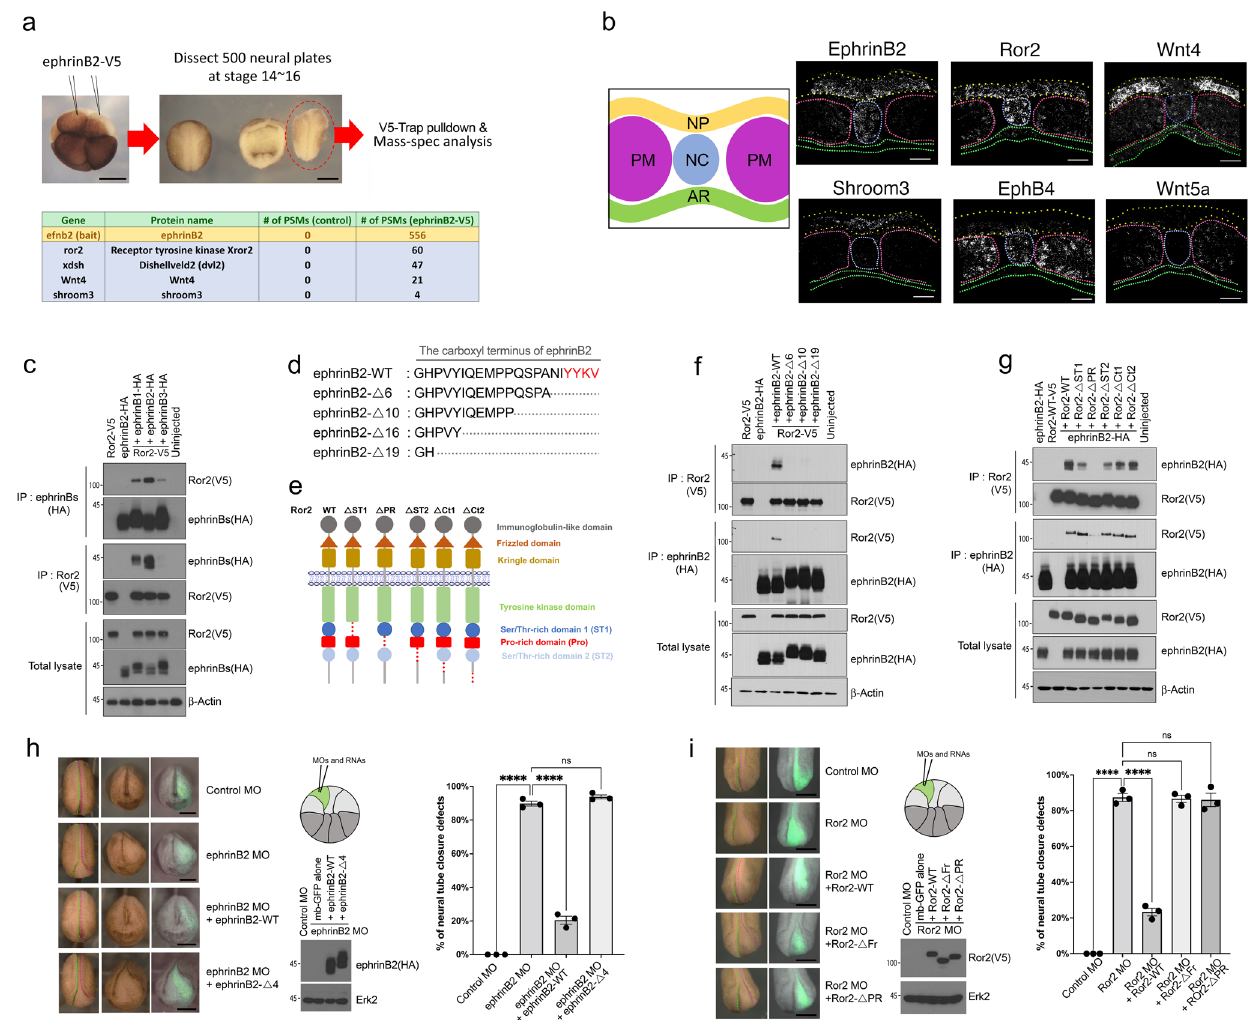
Fig. 1 | ephrinB2/Ror2 interaction regulates apical constriction. a Schematic of screening for ephrinB2-binding partners and selected candidates from ephrinB2 pulldown assay. Scale bar, 500 μ m. See also Supplementary Data 1. b Schematic of the transverse section through neural plate and RNA in situ hybridization (HCR) assay.Neuralplate(yellow),PM;pre-somaticmesoderm(magenta),NC;notochord (blue),AR;archenteronroof(green).Scalebar,50 μ m. c Co-IPassaywithRor2(1ng) and ephrin-B type ligands (500pg) at Stage 13 Xenopus embryos. d Schematic of ephrinB2 serial deletion mutants in C-terminus. The PDZ-binding motif in red. e Schematic of Ror2 serial deletion mutants in the tail region. f Co-IP with Ror2 (1ng) and ephrinB2 (500pg) serial deletion mutants. g Co-IP with ephrinB2 (500pg) and Ror2 serial deletion mutants (1ng). h Representative embryo mor- phology by ephrinB2 knockdown (2ng of MO). See also Supplementary Movie 1. Schematic of D1.1 microinjection in the 16-cell stage embryo. Membrane-GFP indicates injected side (50pg). The lateral boundaries of the neural plate are marked by dotted lines (green; uninjected side and magenta; injected